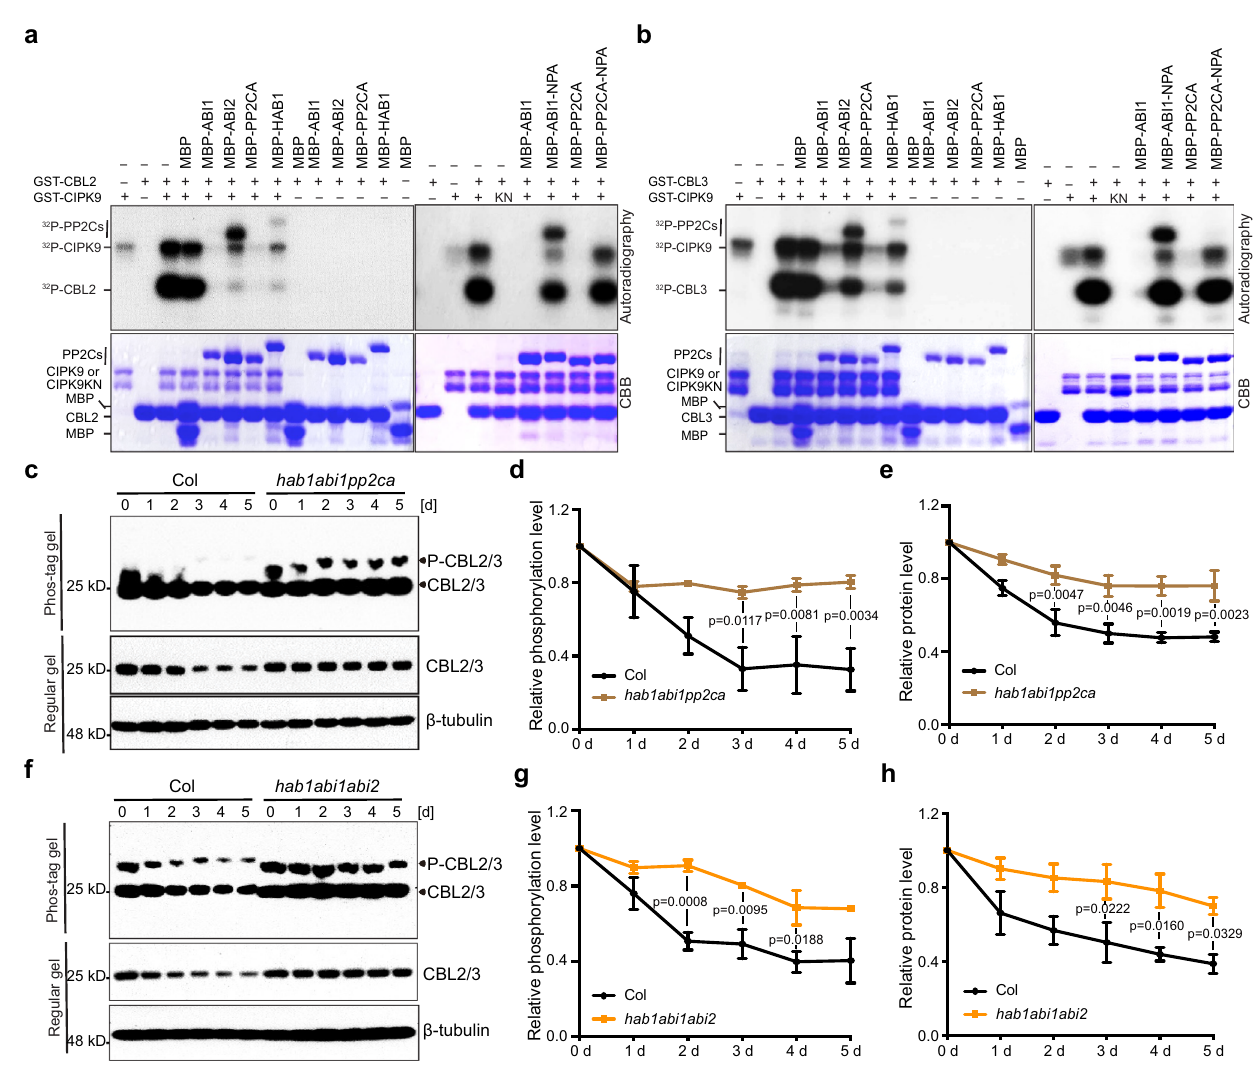
Fig. 4 | HAB1/ABI1/ABI2/PP2CA phosphatases are responsible for CBL2/3 dephosphorylation upon K + -repletion. a, b In vitro kinase assays using either GST-CBL2 ( a ) or GST-CBL3 ( b ) as substrate for CIPK9 or kinase-dead CIPK9-KN mutant in the presence or absence of different PP2C members. Phosphorylated proteins were separated by SDS-PAGE gels and detected by autoradiography (upper panel). Total proteins were quanti fi ed in Coomassie-stained SDS-PAGE gels (bottompanel).Theexperimentswererepeatedthreetimesandonerepresentative image is shown. c Phosphorylation and protein levels of CBL2/3 in Col and hab1abi1pp2ca triple mutant after low- to high-K + transfer. d , e Quanti fi cation of CBL2/3 phosphorylation level ( d ) and protein level ( e ) shown in c . f Phosphorylation and protein levels of CBL2/3 in Col and hab1abi1abi2 triple mutant after low- to high-K + transfer. g, h Quanti fi cation of the CBL2/3